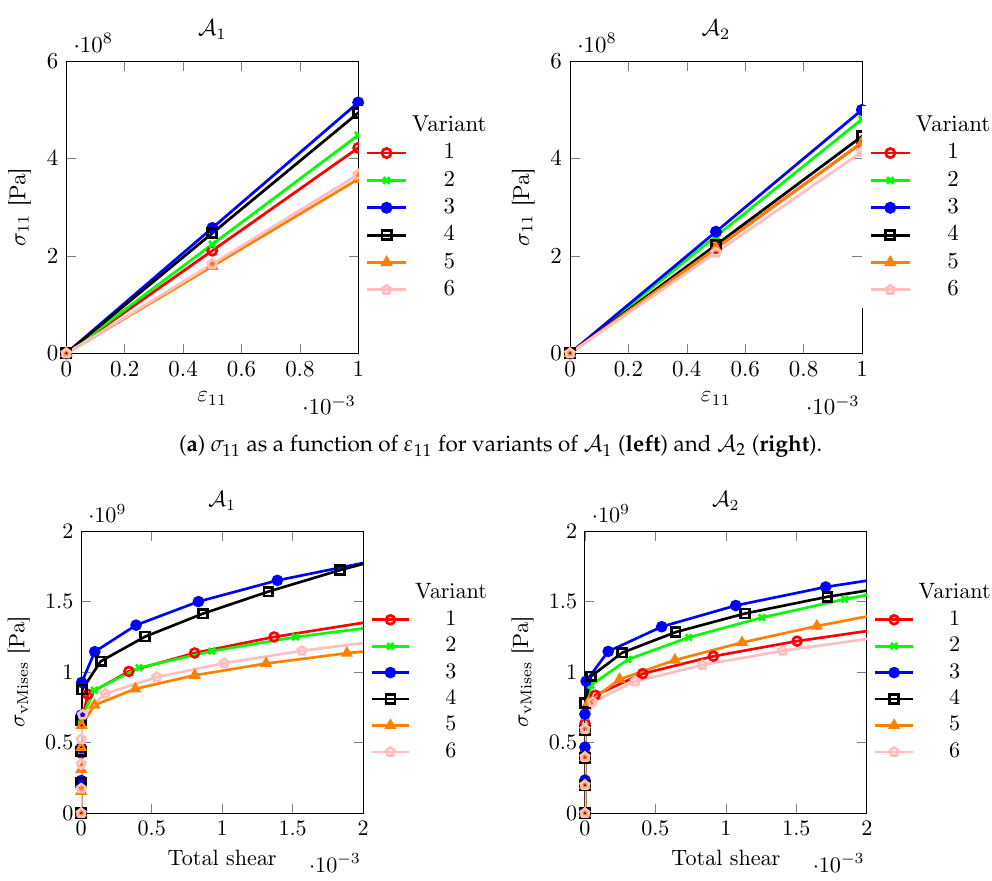
( left ) and ( right ) by Equation (6) and A 1 A 2